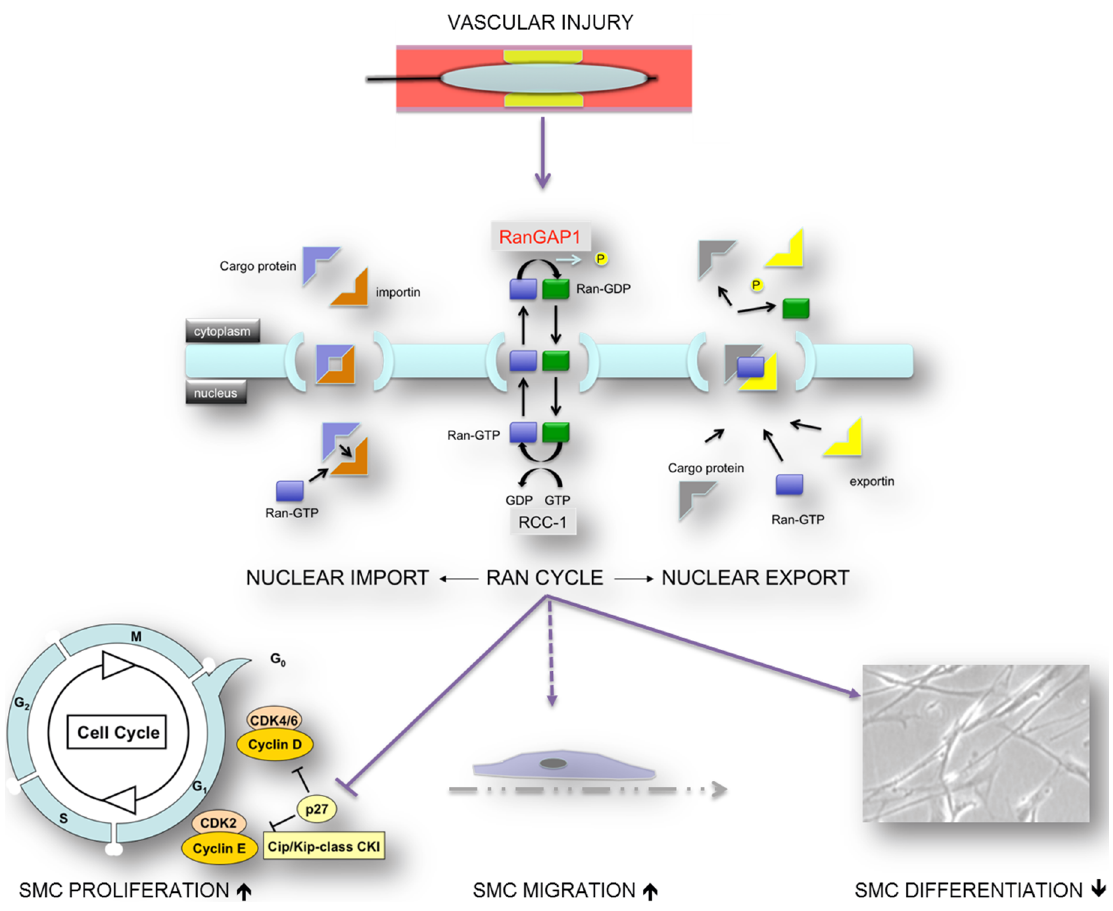
Figure 5. Model: RanGAP1, a key player in nucleocytoplasmic transport, plays a critical role in smooth muscle cell differentiation, migration and proliferation. Appropriate modulation of RanGAP1 expression may thus be a strategy to modulate vascular proliferative disease development such as restenosis.